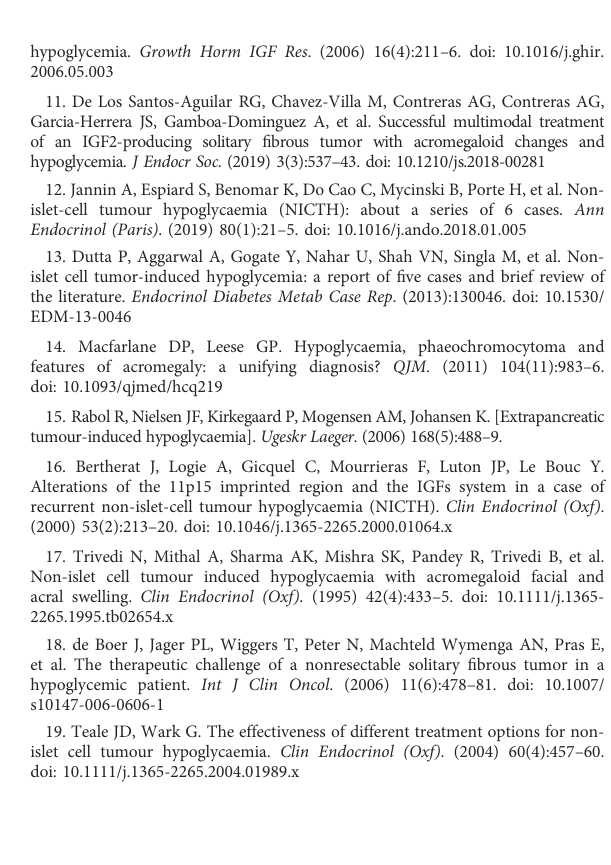
SUPPLEMENTARY FIGURE 1 Macroscopic view of the resected tumor. SUPPLEMENTARY FIGURE 2 Immunostaining for Ki-67